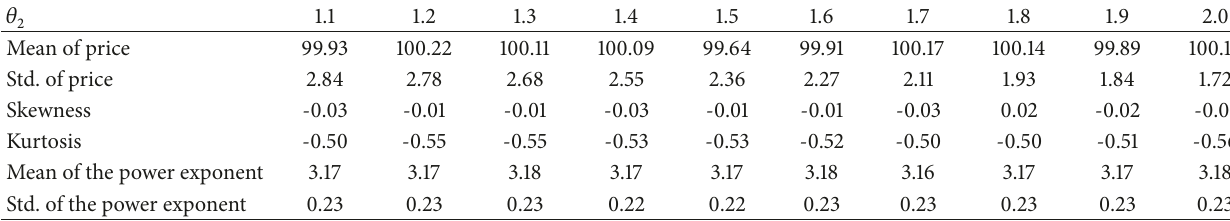
Table 1: Sensitivity analysis of threshold 𝜃 2 .